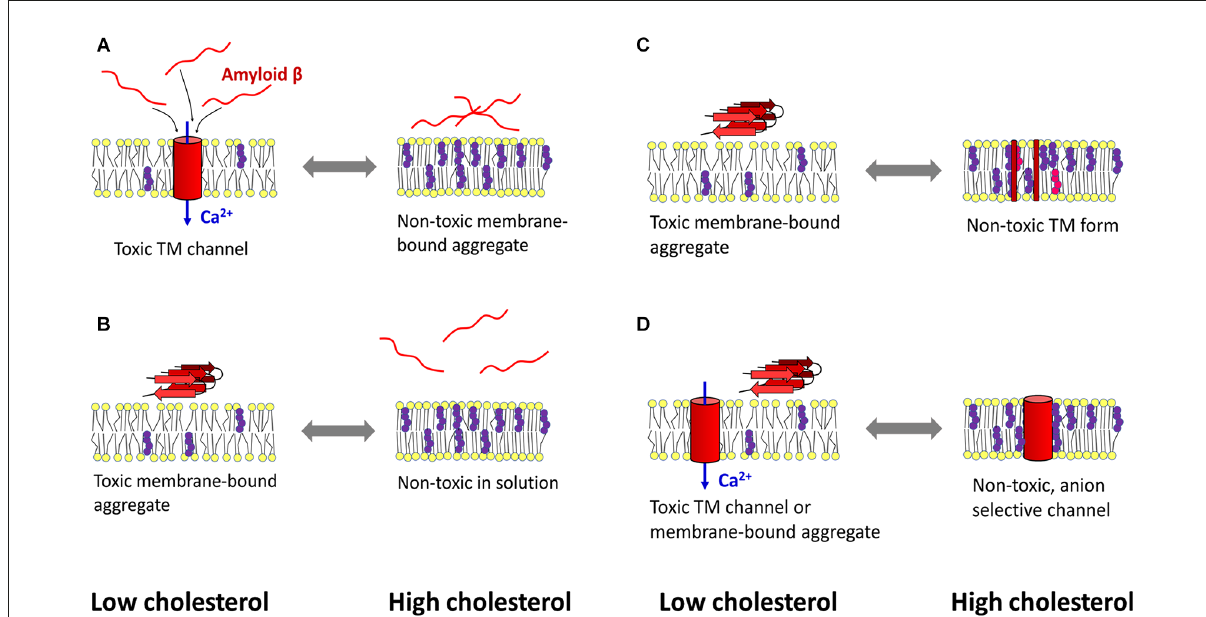
FIGURE2 Mechanisms of cholesterol-mediated protection against amyloid β toxicity. (A) Left: under cholesterol-deficient conditions, amyloid β (A β ) penetrates the membrane and aggregates in calcium-selective pores, leading to calcium dyshomeostasis and cytotoxicity. Right: cholesterol- inducedrigidizationofthemembranepreventsamyloidpeptidefromenteringthebilayer. (B) Anothermechanismdesignatescholesterolasalipid that reduces the ability of A β to bind the membrane. (C) A cholesterol-rich membrane (which may also contain oxysterols) retains A β peptides in a transmembrane (TM), non-toxic form. At low cholesterol levels, A β can self-organize into toxic aggregates at the membrane surface. (D) A β forms calcium-selective TM channels when the bilayer has low cholesterol content, whereas high cholesterol concentration induces the formation of non-toxic, anion-selective pores. Red—amyloid β , yellow—membrane lipids, purple—cholesterol, pink—oxysterol, blue—calcium influx into the cytosol. The scheme was prepared according to Arispe and Doh (2002), Curtain et al. (2003), Micelli et al. (2004), Qiu et al. (2009), Qiu et al. (2011), Meleleo et al. (2013), Evangelisti et al. (2014), Phan et al. (2014, 2018), Bode et al. (2017), Fernandez-Perez et al. (2018), and Meleleo et al.